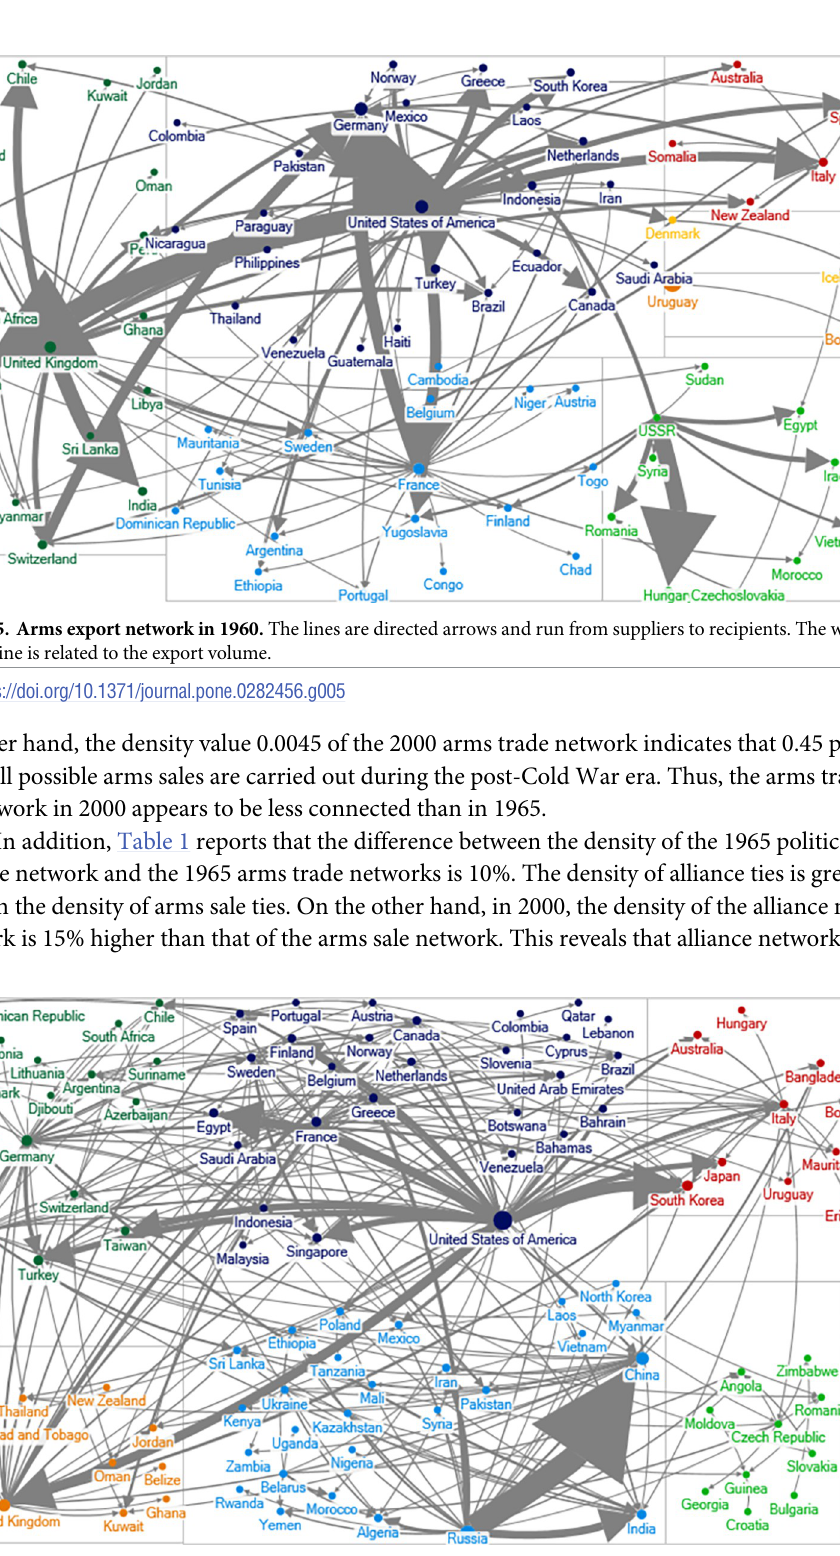
Fig 6. Arms export network in 2000. The lines are directed arrows and run from suppliers to recipients. The width of the line is related to the export volume.